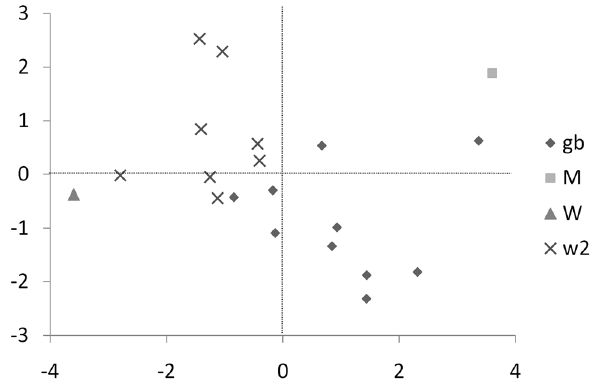
Figure 3. Canonical discriminant analysis of the leaf chemicals from two sibling populations with different paternal parent- ages. W2 = Waldin siblings (N=8 trees); gb = General Bureau siblings (N=10 trees); M = Melendez (n=2 samples per tree, maternal parent of all siblings); W = Waldin (n=2 samples per tree, paternal parent of Waldin